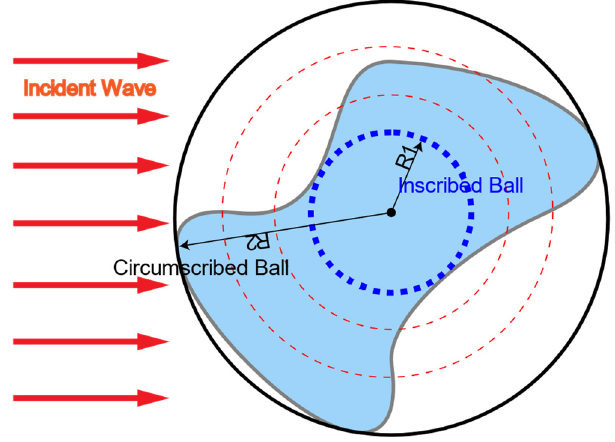
Figure 1. Cross section diagram of non-spherical particles. In the figure, R1 is the maximum inscribed sphere radius and R2 is the minimum circumscribed sphere radius.